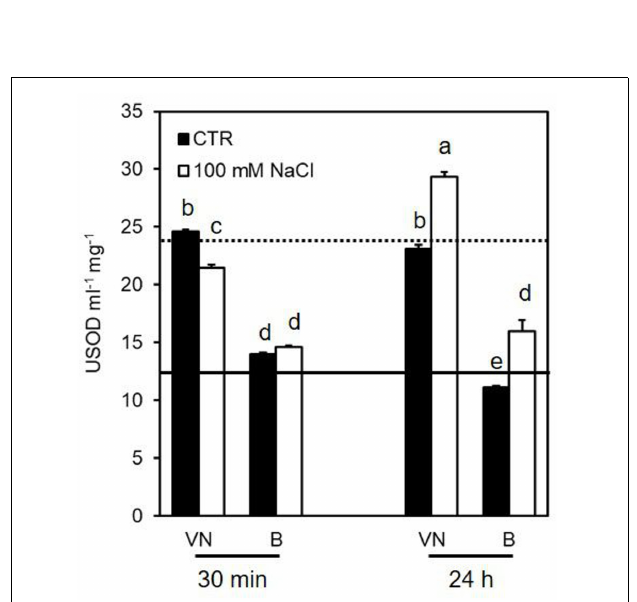
FIGURE 6 | Effect of 100 mM NaCl on SOD activity determined at 30 min and 24 h after treatment. Values represent the mean ± SE of three independent experiments at least in duplicate. The lines represent average enzymatic activity in control conditions of VN (straight line) and B (dotted line). Different letters indicate significantly different activity levels according to one-way ANOVA ( p <